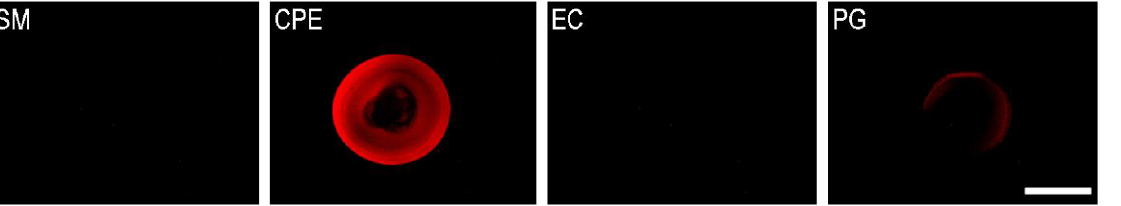
Figure 5. Dot blot images of EryA-mCherry binding to commercial lipids and lipid extracts from bacteria. Lipid standards (20 µg SM, 14 µg CPE) and 20 µg of lipid extracts from E. coli and P. gingivalis were applied on a nitrocellulose membrane, incubated with EryA-mCherry (2 µg/mL) and the intensity of fluorescence was measured. Scale bar: 2.5 mm. Abbreviations: SM, sphingomyelin; CPE, ceramide phosphoethanolamine; EC, E. coli ; PG, P. gingivalis .